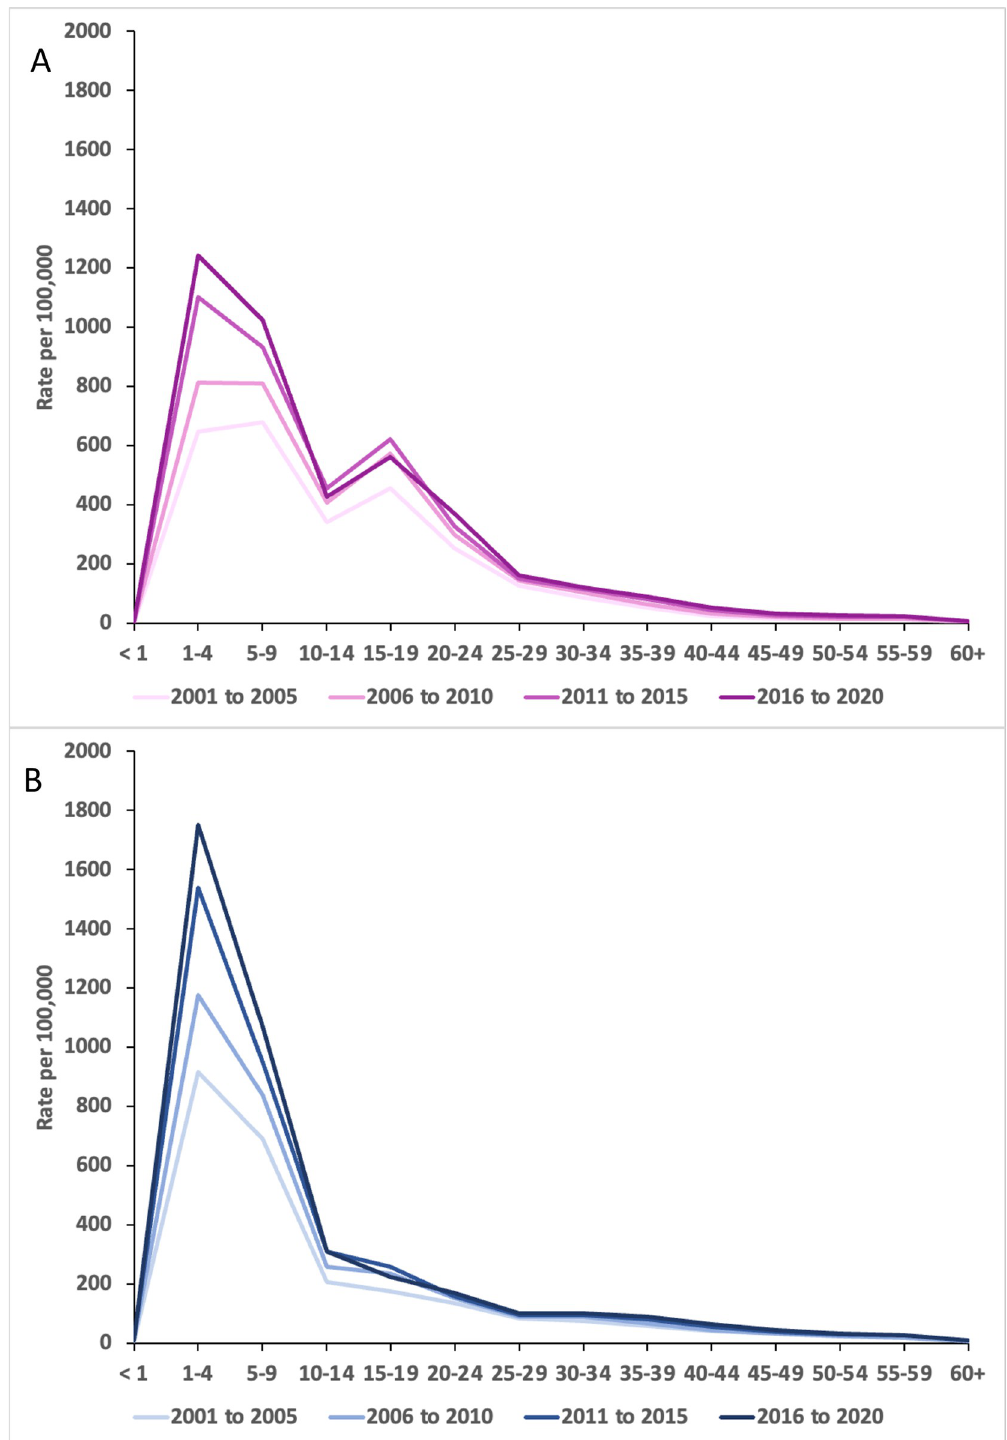
Fig 5. Age-specific incidence of tonsillectomy procedures for males and females, 2000–01 to 2019–20.